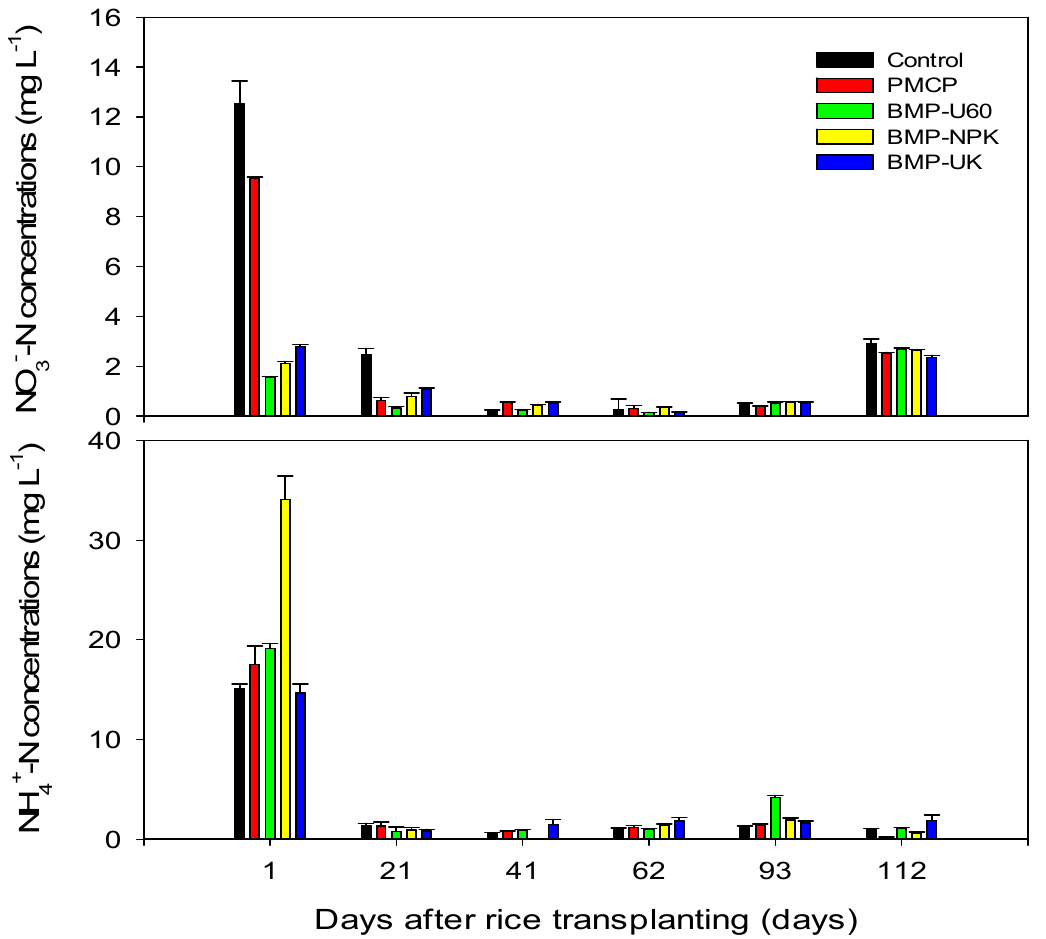
Figure 2. Effects of different treatments on NH 4+ –N and NO 3 − –N contents in rice surface paddy water during rice cultivation. The values displayed are averages of triplicate samples with standard deviation.